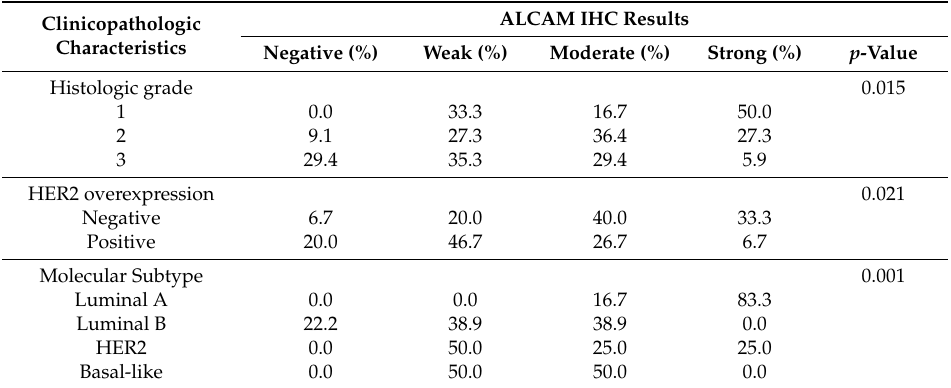
Table 3. Association between the clinicopathologic characteristics and the ALCAM IHC results in tumor tissues.